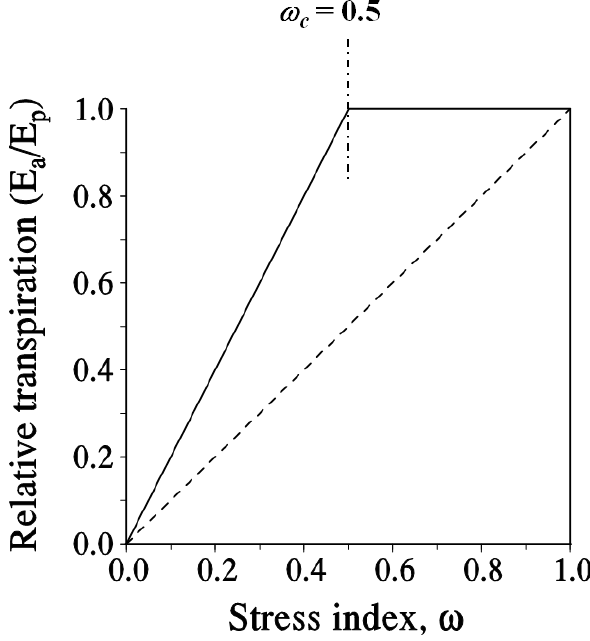
Fig. 1. Water stress, compensation and transpiration predicted by the simple physics-based model. In this example, the solid line il- lustrates a compensated model with ω c = 0 . 5, while the uncompen- sated case ( ω c = 1) is illustrated by the dashed